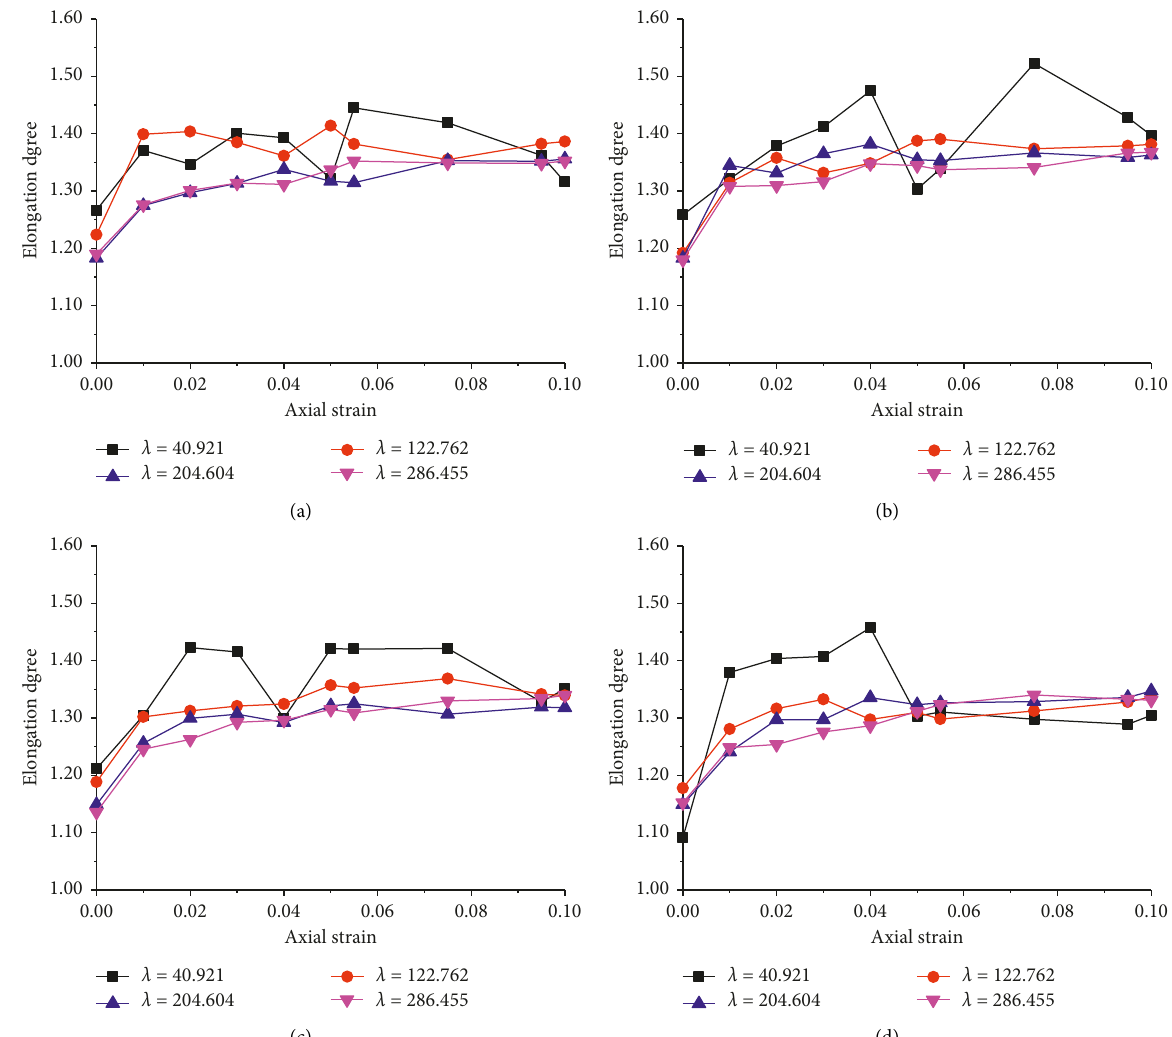
Figure 14: Evolution of elongation degree of void cells in RVEs with various heights and particle sizes. (a) RVEs with various heights at 0g. (b) RVEs with various particle sizes at 0g. (c) RVEs with various heights at 5 g. (d) RVEs with various particle sizes at